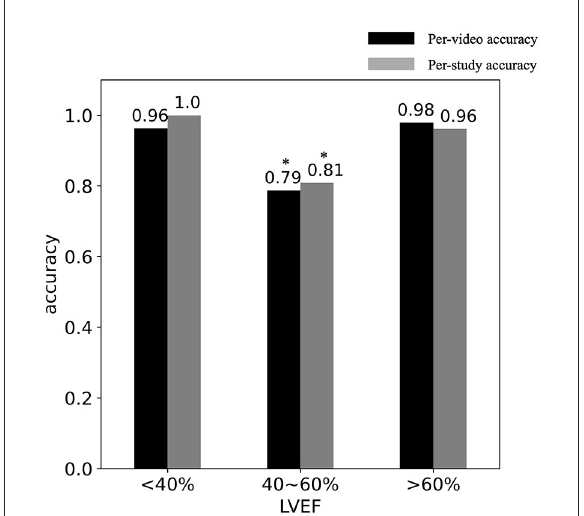
FIGURE3 DL classification accuracy vs. LVEF. The per-video (black) and per-study (gray) accuracy are shown in studies with (LVEF